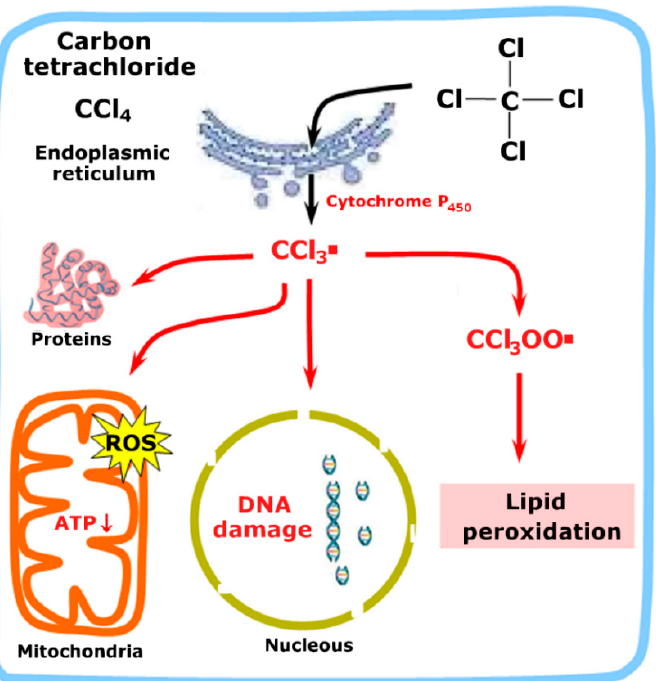
Figure 1. Main events of the carbon tetrachloride-induced liver injury. CCl 3 · is the trichloromethyl radical while CCl 3 OO · is the trichloromethylperoxy radical. A more detailed description can be found in the